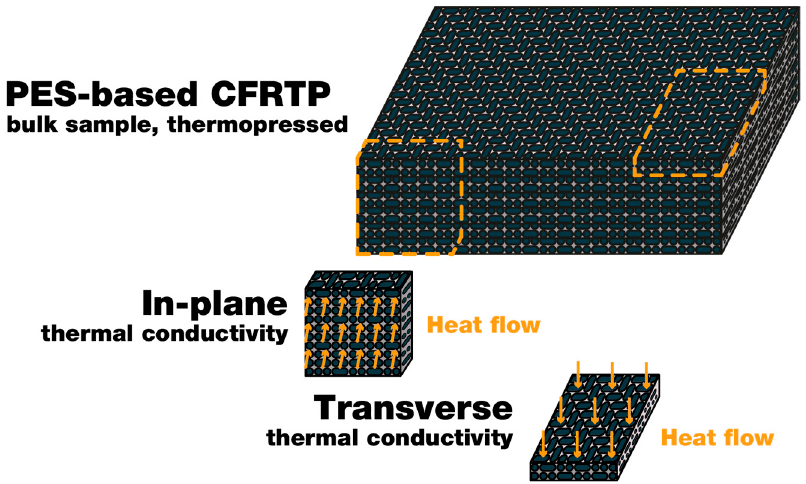
Figure 4. Principle scheme for measuring thermal conductivity of composites.